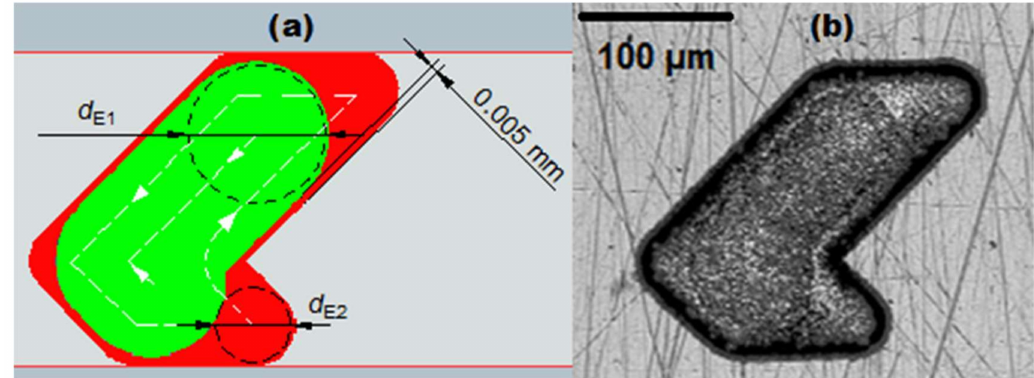
Figure 6. ( a ) Depiction of the 2-electrode strategy for machining of the SH groove. 5 µ m band is left by larger electrode d E1 , thus, its diameter is determined by: d E1 = a – 2 × l GAP – 2 × 5 µ m. ( b ) Confocal microscope image of the SH groove machined with d E1 = 92 µ m and d E2 = 44 µ m ( d = 100 µ m, a = 106 µ m, r G = 25 µ